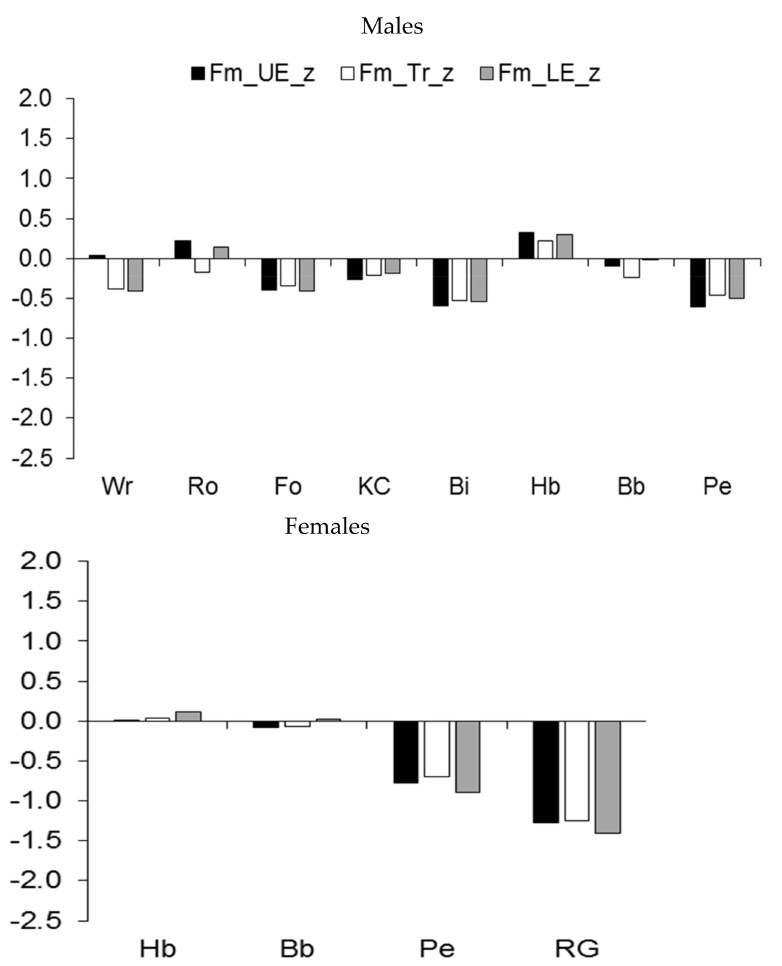
Figure 6. Median z-scores for fat mass (expressed as a percentage of stature) of the upper extremities (UE), trunk (Tr), and lower extremities (LE) in youth athletes by sport. The pattern of BMD in the extremities and the trunk expressed as a percentage of total BMD (BMD%) in the total samples of male and female athletes suggested that the mechanical load on the human body varied by the position of the regions relative to posture (bipedal standing or bipedal movement). The higher the position of the region in the human body, the lower the BMD% (Figure